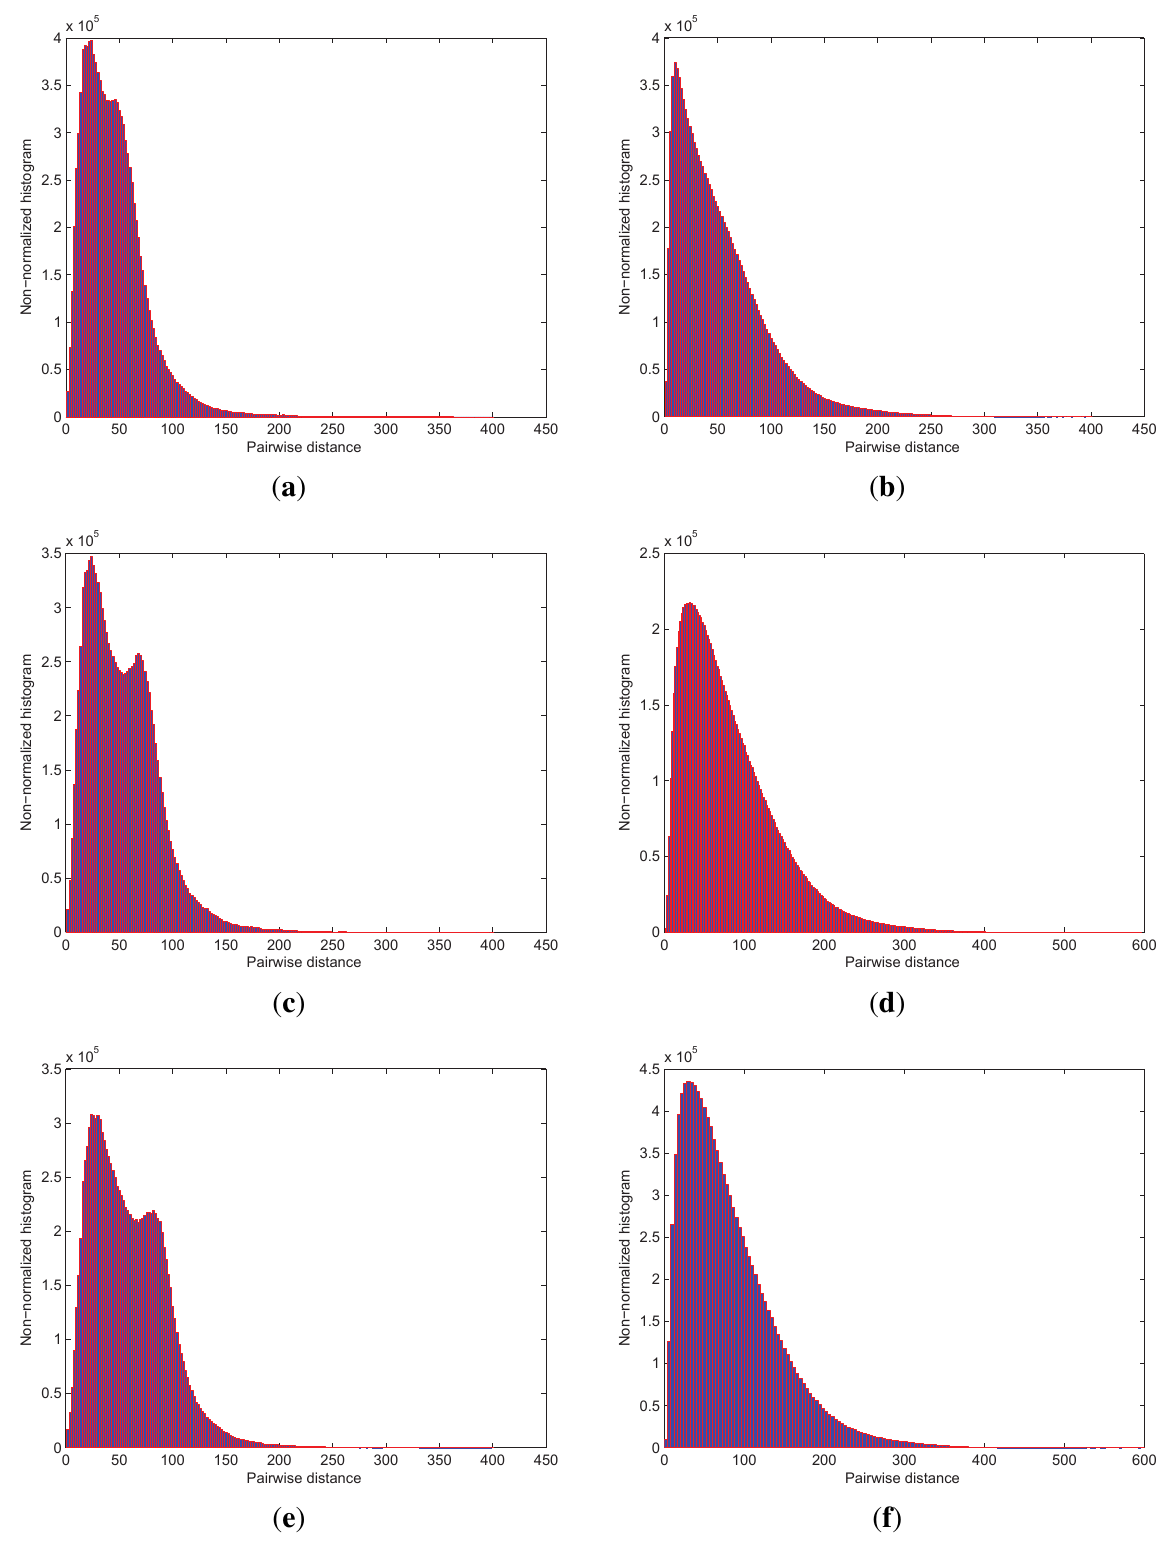
Figure 2. Non-normalized histograms of pairwise distances: ( a ) Moffet _ igm with 02 1 ∼ 60 bands; ( b ) Cuprite with 1 ∼ 60 bands; ( c ) Moffet _ igm with 1 ∼ 100 bands; 02 02 ( d ) Cuprite with 1 ∼ 100 bands; ( e ) Moffet _ igm with all available bands ( 1 ∼ 206 ); 02 02 and ( f ) Cuprite with all available bands ( 1 ∼ 197 02